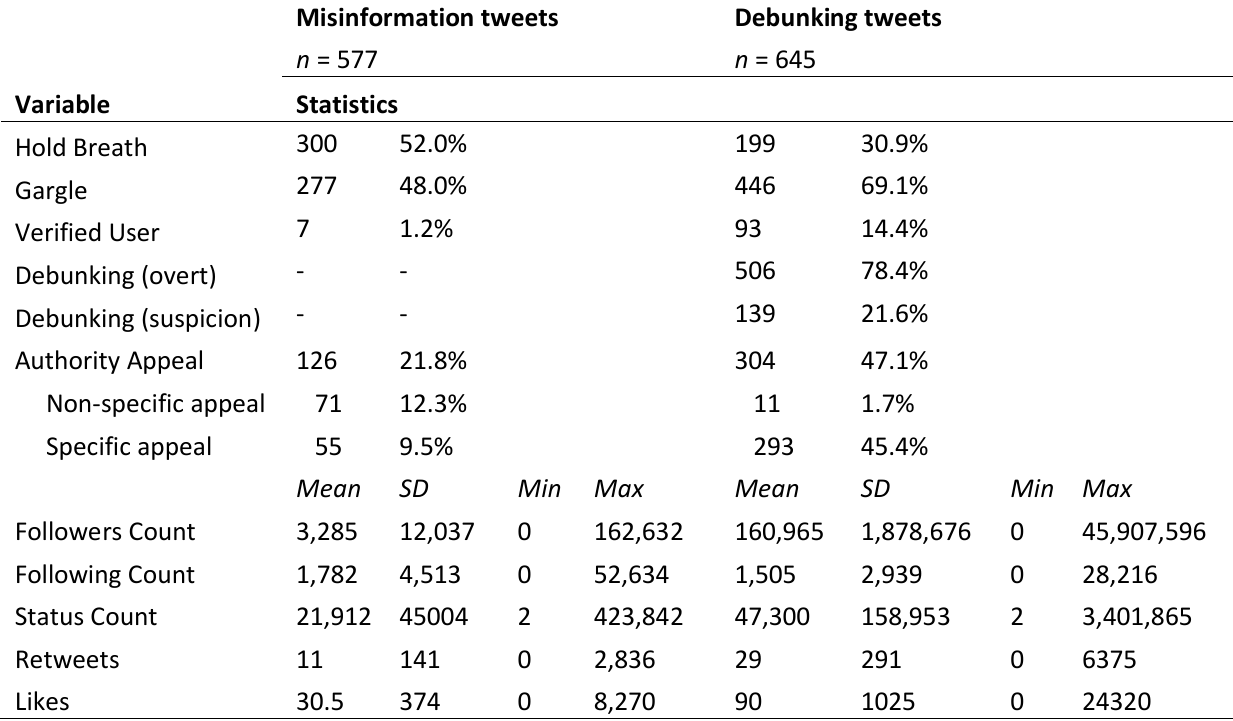
Table 1 . Descriptive s tatistics of the analyzed